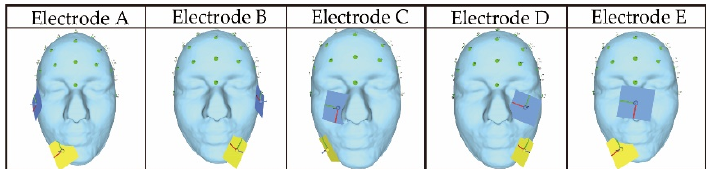
Figure 3. Electrode arrangements were used in the previous study for stimulating the lower human eyeball; the figures were produced by the authors using SimNIBS (03/11/2022).